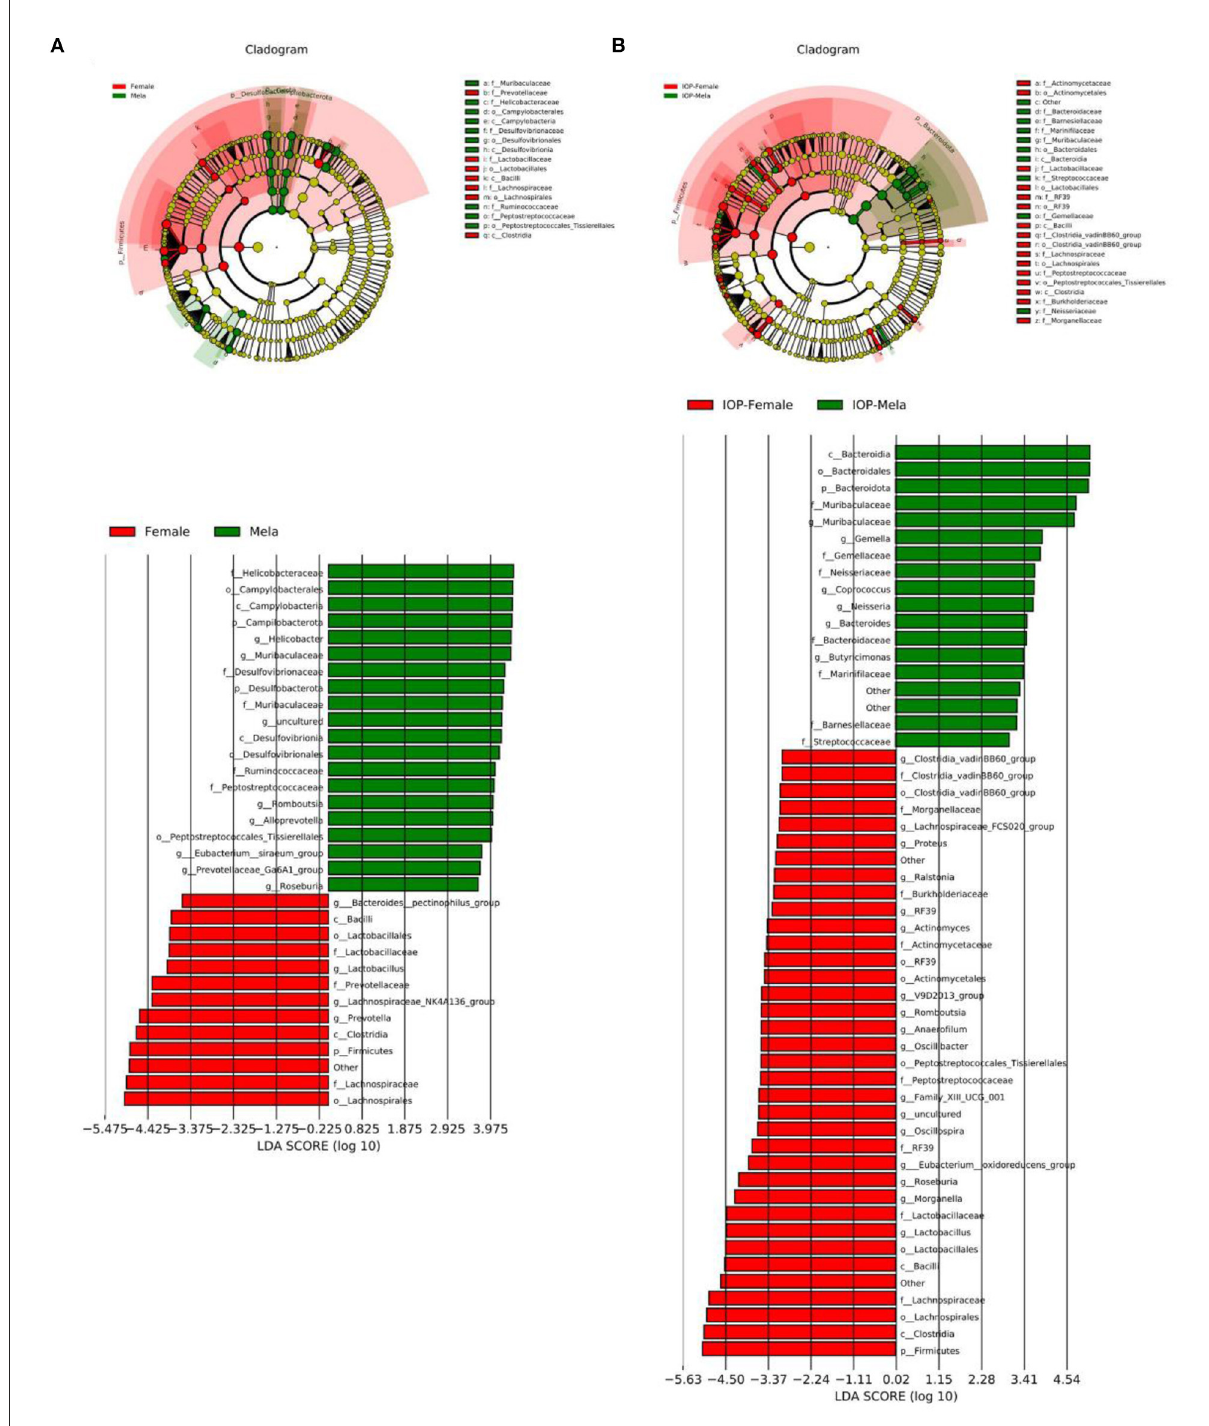
FIGURE7 The control group (A) and the experimental group (B) with IOP interference were compared. Results of linear discriminant analysis were used to determine the dominant species after IOP